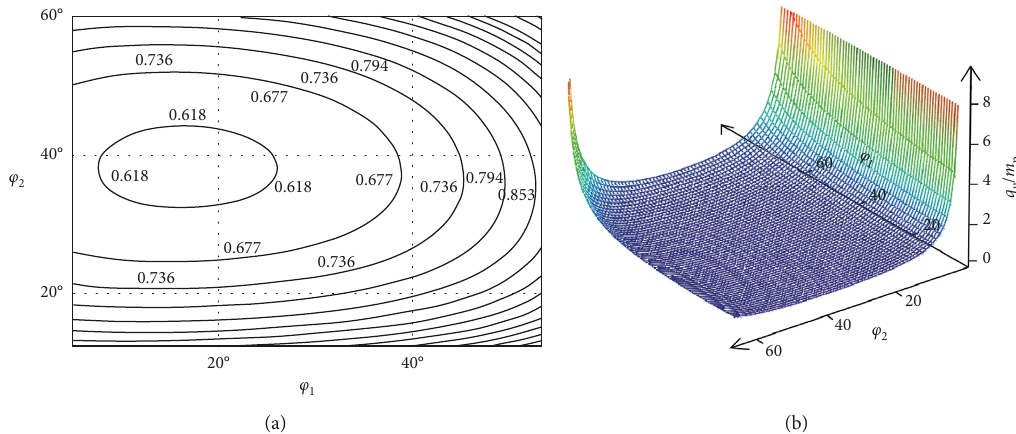
Figure 5: Contour plot (a) and 3D diagram (b) of the objective function q